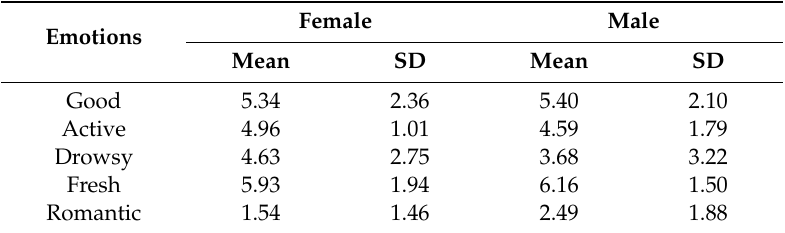
Table 3. Mean and SD of emotional state after in tangerine oil